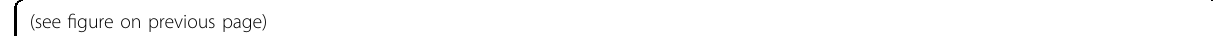
Fig. 3 Separation and identi fi cation of SFC-derived exosome-like vesicles and the effect of SFC-miR-126-3p-Exos administration on chondrocytes. A Rat SFC was isolated and cultured in cell culture media. Then the supernatant exosome-like vesicles extracted using ultracentrifugation assay were subjected to NanoSight detection. B The miRNA expression (miR-126-3p) of SFC transfected with miR-126-3p mimic (100pM) was detected by qRT-PCR for 24 h incubation. C The indicated protein levels (CD9, CD63, and HSP70) in exosome-like vesicles were detected by western blotting. D The morphology of exosome-like vesicles was observed under TEM and NanoSight detection was measured. E Cell proliferation treated by SFC-miR-126-3p-Exos was determined by CCK-8 at concentrations of 2 × 10 9 /mL for 24 and 48 h. F Apoptotic index was determined using fl ow cytometry in the presence of SFC-miR-126-3p-Exos (2 × 10 9 /mL) for 2 h before 0.75 mM SNP co-treatment for 24 h. In this study, 0.75 mM fresh SNP was used to induce chondrocyte in fl ammation. G The miRNA (miR-126-3p) and mRNA expression (IL-1 β , IL-6, and TNF- α ) were detected by qRT-PCR in the presence of SFC-miR-126-3p-Exos (2 × 10 9 /mL) for 2 h before 0.75 mM SNP co-treatment for 24 h. H Western blot assay was used to detect in fl ammation-related (IL-1 β , IL-6, and TNF- α ) proteins in the presence of SFC-miR-126-3p-Exos (2 × 10 9 /mL) for 2 h before 0.75 mM SNP co-treatment for 24 h. Data were expressed as mean ± SEM ( n = 3). * P < 0.05, ** P < 0.01, and *** P < 0.001 vs. miR-Control-Exo; # P < 0.05, ## P < 0.01, and ### P < 0.001 vs. SNP +